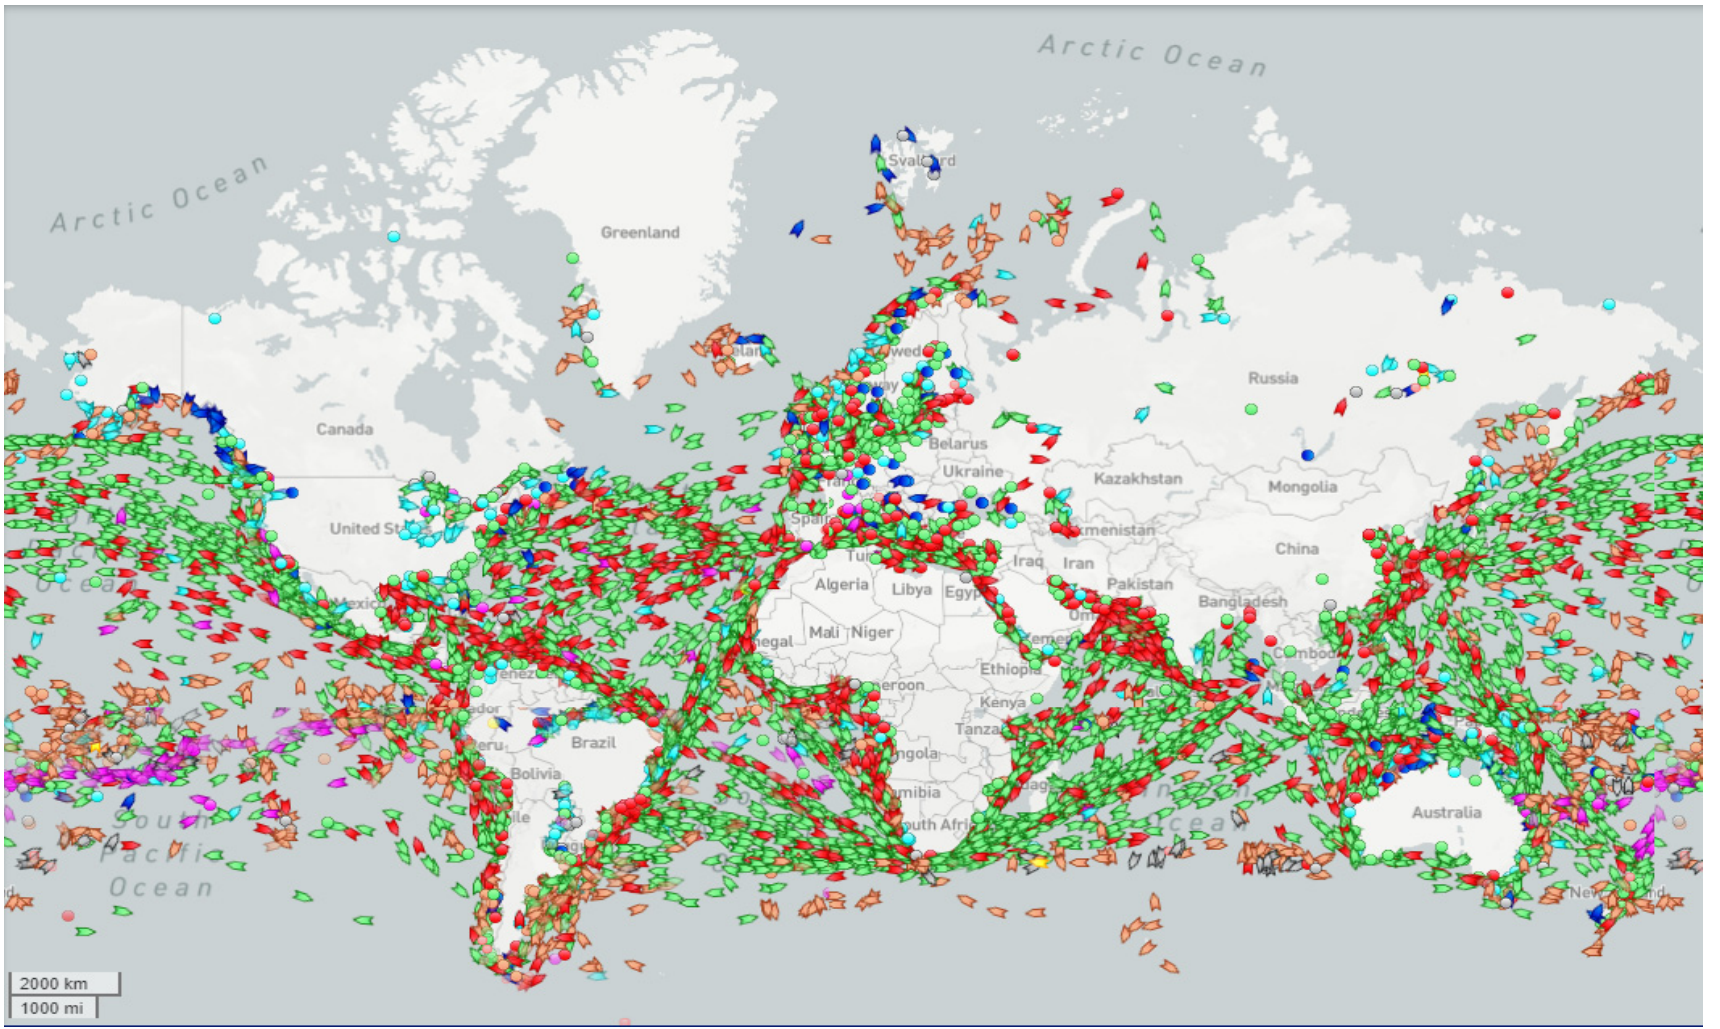
Figure A2. Map of all the ships showing their real-time positions globally at sea, with data obtained through monitoring (MarineTraffic.com, accessed on 5 June 2022).